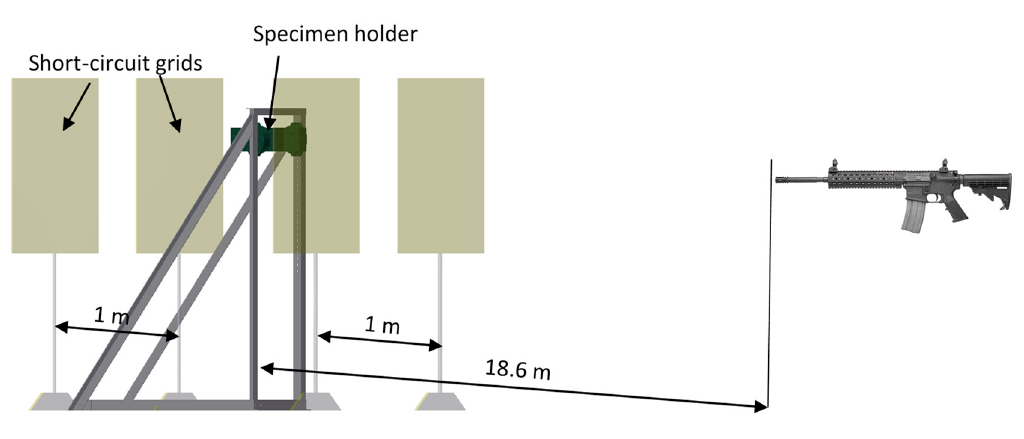
Figure 2. Arrangement of measuring devices in the shooting range.